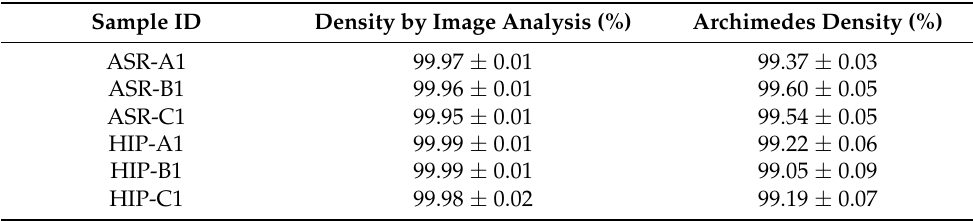
Table 4. Density of the ASR and HIP Ti-6Al-4V ELI alloy samples.